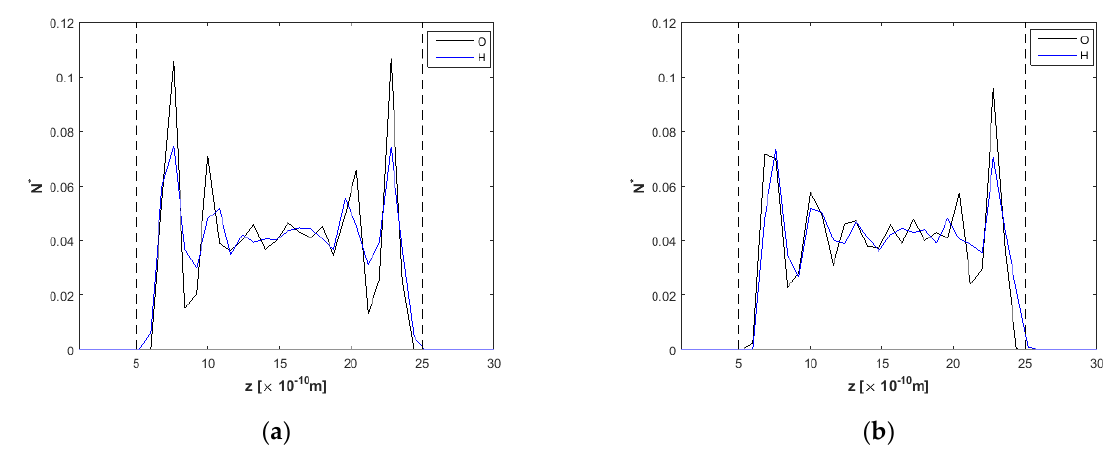
Figure 6. Density profiles for O and H, F ext = 0.025 kcal / molÅ and h = 2.0 nm, ( a ) at t = 5 ns, E = 0.0 V / Å and ( b ) at t = 20 ns, E = 2.0 V / Å. Dashed lines denote wall limits.